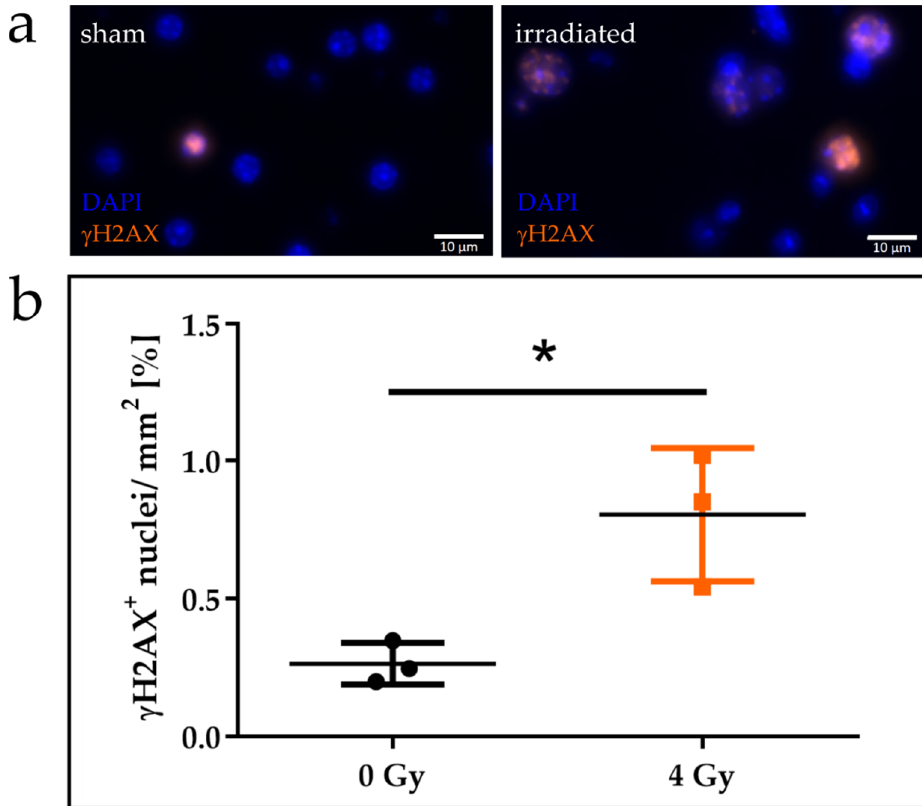
Figure 7. Formation of γH2AX signal in organotypic brain slice cultures irradiated with 10 Gy protons. ( a ) Irradiated slices show a higher number of γH2AX positive cells. However, the typical spot-like foci formation is missing (blue—cell nuclei, orange—γH2AX). ( b ) The percentage of γH2AX positive nuclei (mean with SD) in non-irradiated and proton irradiated organotypic brain slices revealed a significant increase after proton irradiation (unpaired, two-tailed t -test, n = 3, *: p = 0.02).